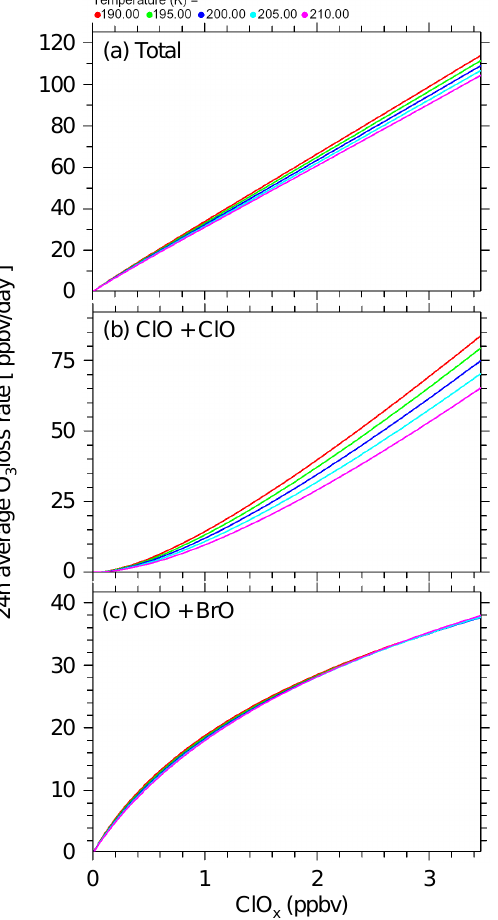
Figure 1. 24h ozone loss as a function of ClO x mixing ratios at 50hPa. (a) Total, (b) by the ClO + ClO catalytic cycle and (c) by the ClO + BrO catalytic cycle.